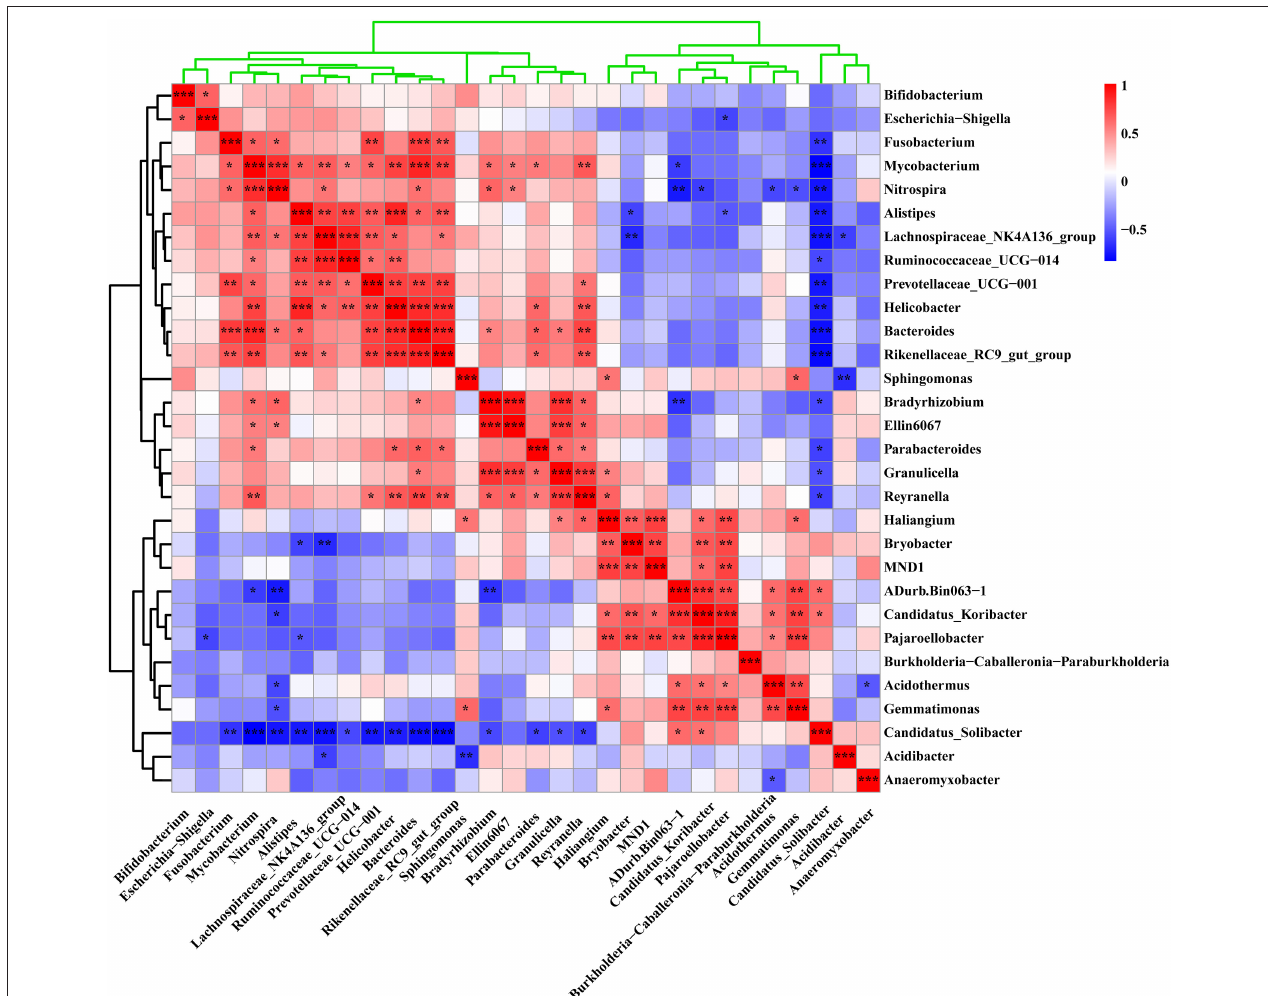
FIGURE 7 | Correlation analysis of the 30 genera with the highest relative abundance in the sample. The color bar in the upper right corner represents the Pearson correlation index of different samples. The blue color block indicates that there is a negative correlation between different samples, while the red color block indicates that there is a positive correlation between different samples. * Indicates a significant correlation between samples at the level of P < 0.05, **Indicates a significant correlation between samples at the level of 0.01 < P < 0.01, while *** indicates a significant correlation between samples at the level of P < 0.001.